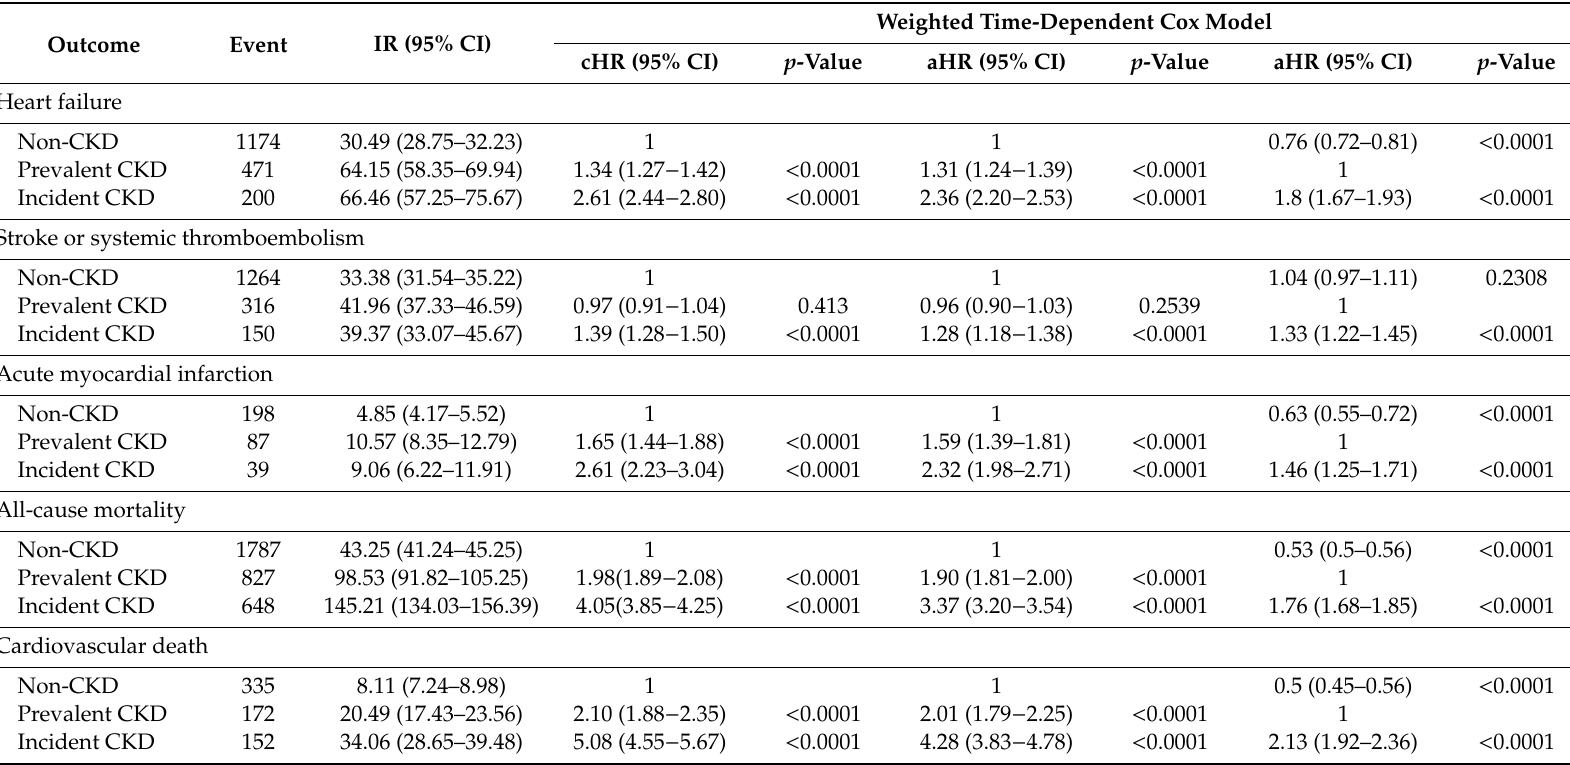
Table 2. Risks for heart failure, stroke or systemic thromboembolism, acute myocardial infarction and mortality among patients with AF by CKD